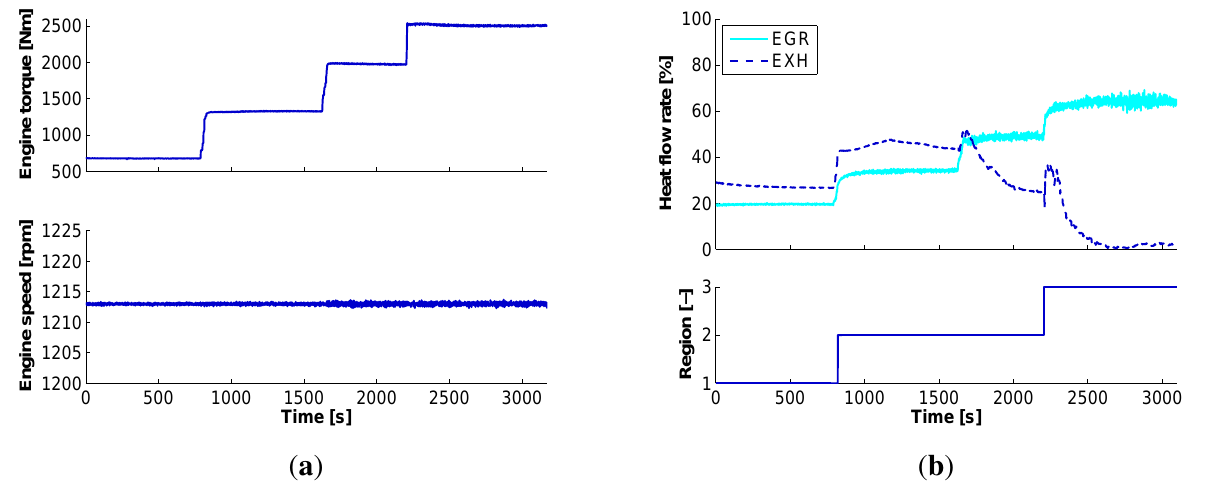
Figure 8. Vapor fraction after the exhaust gas recirculation (EGR) evaporator, exhaust (EXH) evaporator, mixing junction together with the control input for the model predictive control (MPC)